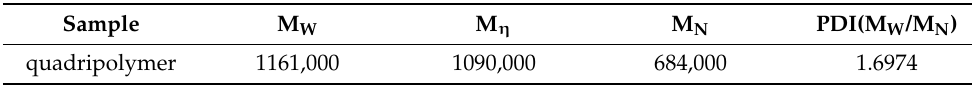
Table 2. Molecular weight indexed of